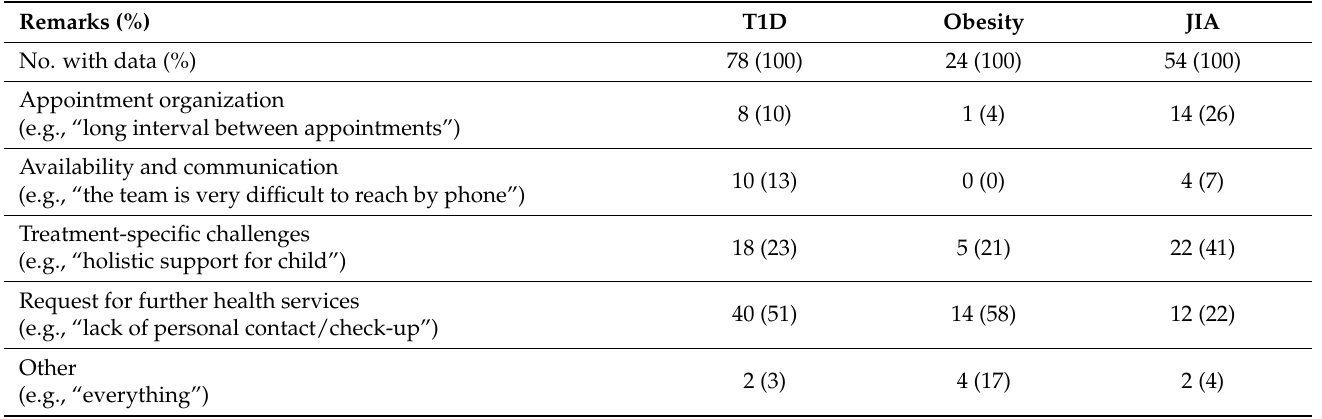
Table 3. Reported obstacles experienced related to health services during the COVID-19